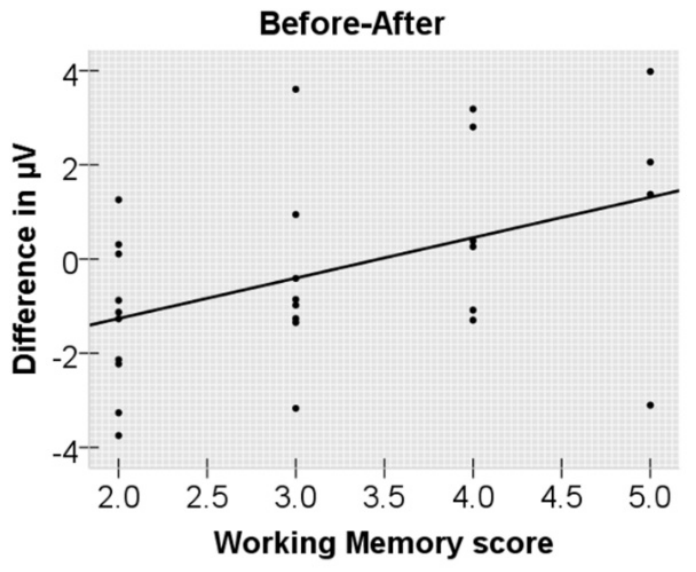
Figure 4. Correlation of working memory score and ERP voltage difference (at the connectives, 3000–4500 ms) between before and after sentences over the left posterior electrodes.